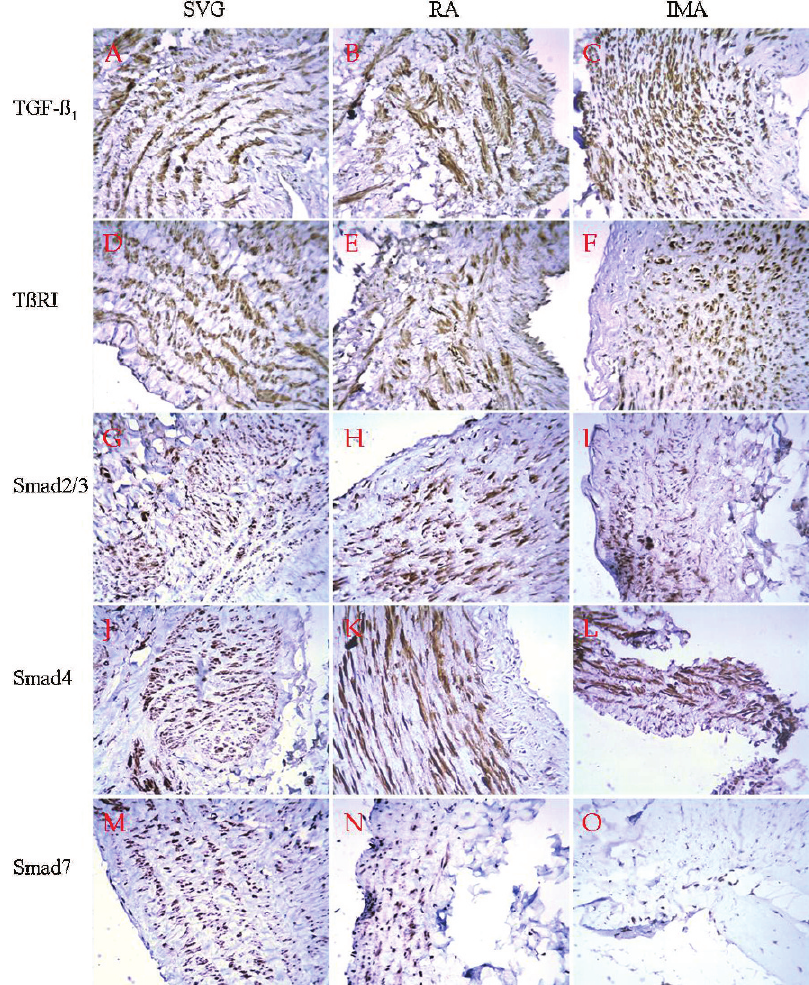
Figure 2 - Immunostaining showed that the five tested proteins (TGF- b 1 , T b RI, Smad2/3, Smad4, and Smad7) were positive, primarily in the cytoplasm of the medial layers, in all three kinds of grafts. (A) (B) In the saphenous vein and radial arterial grafts, TGF- b 1 expression was moderately positive ( ++ ) in the cytoplasm and interstices of the intima, intensely positive ( +++ ) in the cytoplasm and interstices of the media, and weakly positive ( + ) in the cytoplasm and interstices of the adventitia. (C) In the intima ( ++ ), media ( +++ ) and adventitia ( + ) of the internal mammary arterial grafts, TGF- b 1 staining was only observed in the cytoplasm and not in the interstices. In the saphenous vein grafts, T b RI was moderately positive in the cytoplasm and interstices ( + - ++ ) of the intima, intensely positive ( +++ ) primarily in the cytoplasm but also in the nuclei and interstices of the media, and weakly positive ( + ) or negative (-) in the cytoplasm or interstices, respectively, of the adventitia (D). This receptor was positive in the cytoplasm and interstices of the intima ( + ), media ( ++ ) and adventitia ( + ) of the radial arterial grafts (E), and positive in the cytoplasm of the intima ( + ), media ( ++ ) and adventitia ( + ) of the internal mammary arterial grafts (F). Smad2/3 positivity was more intense in the saphenous vein grafts (G) than in the internal mammary arterial grafts (I), whereas the radial artery (H) showed the least intense Smad2/3 staining. In the saphenous vein grafts, Smad4 was weakly positive ( + ) in the cytoplasm of the intima, intensely positive ( +++ ) in the cytoplasm of the media, and weakly positive (-- + ) in the cytoplasm of the adventitia (J). In the radial arteries, it was weakly positive in the cytoplasm ( + ) and negative (-) in the intima, moderately positive ( ++ ) in the cytoplasm and interstices of the media, and weakly positive in the cytoplasm and interstices of the adventitia (K). In the